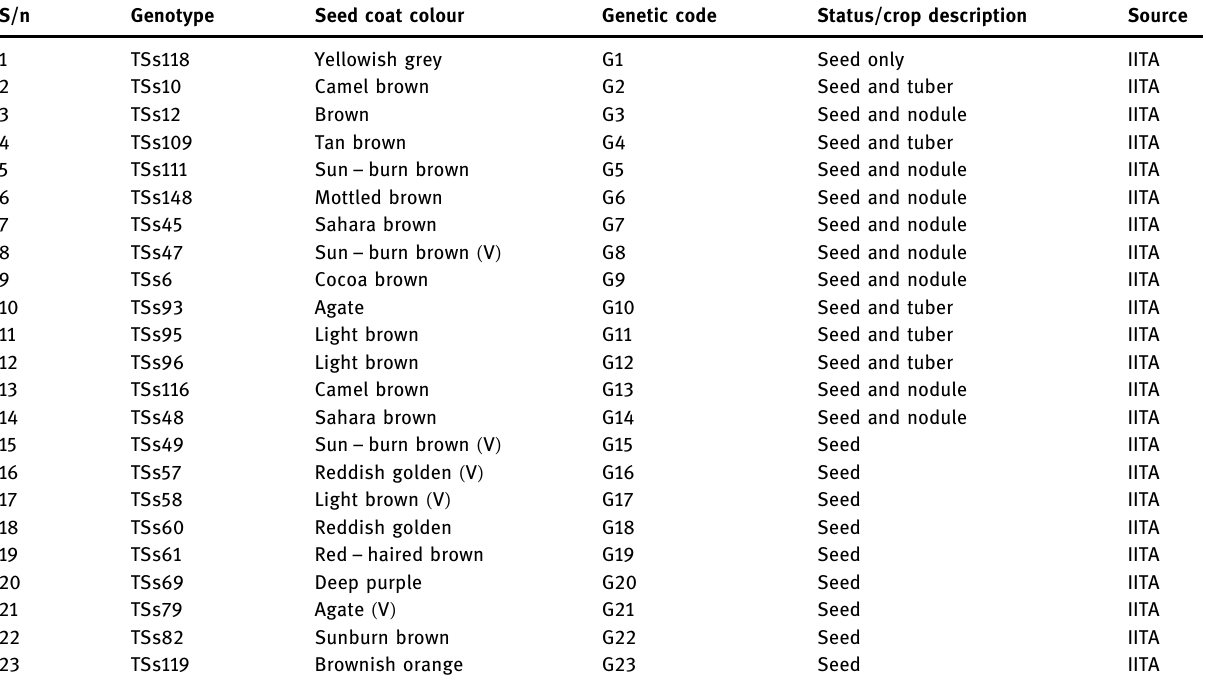
Table 2: Description of the AYB genotypes as sourced in 2010 S/n